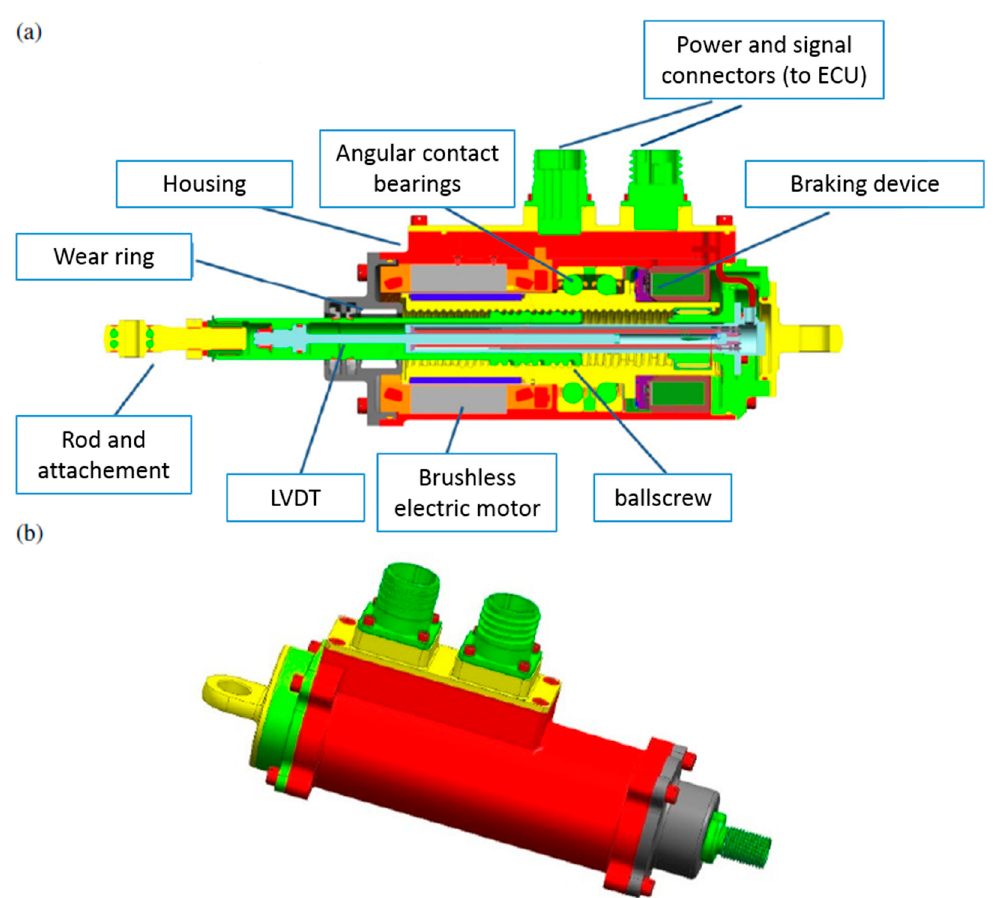
Figure 5. EMA actuators: ( a ) sectional and ( b ) external view, [15].